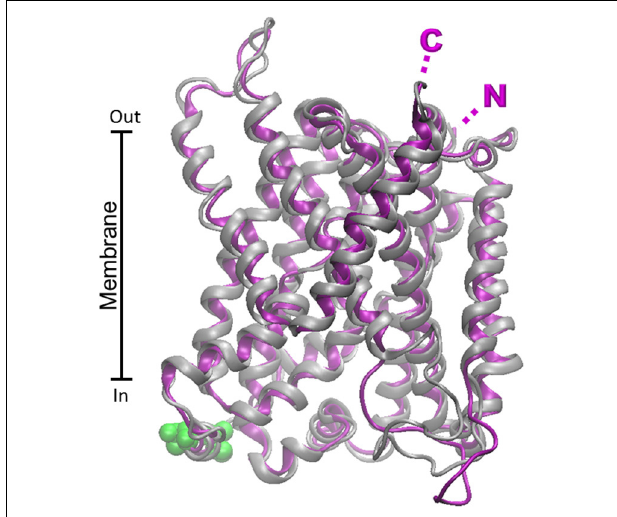
FIGURE 7 | Homology models of SNAT7 human and rat transporters. The homology structural models of rat (purple) and human (Chaudhry et al.) SNAT7 were constructed as described in Figure 6 . Superposition of the rat and human structural models was performed by VMD 1.9.1. Putative PKC and PKA phosphorylation sites are highlighted in green. N- and C- terminals of rat and human proteins are nearly coincident and highlighted by single N and